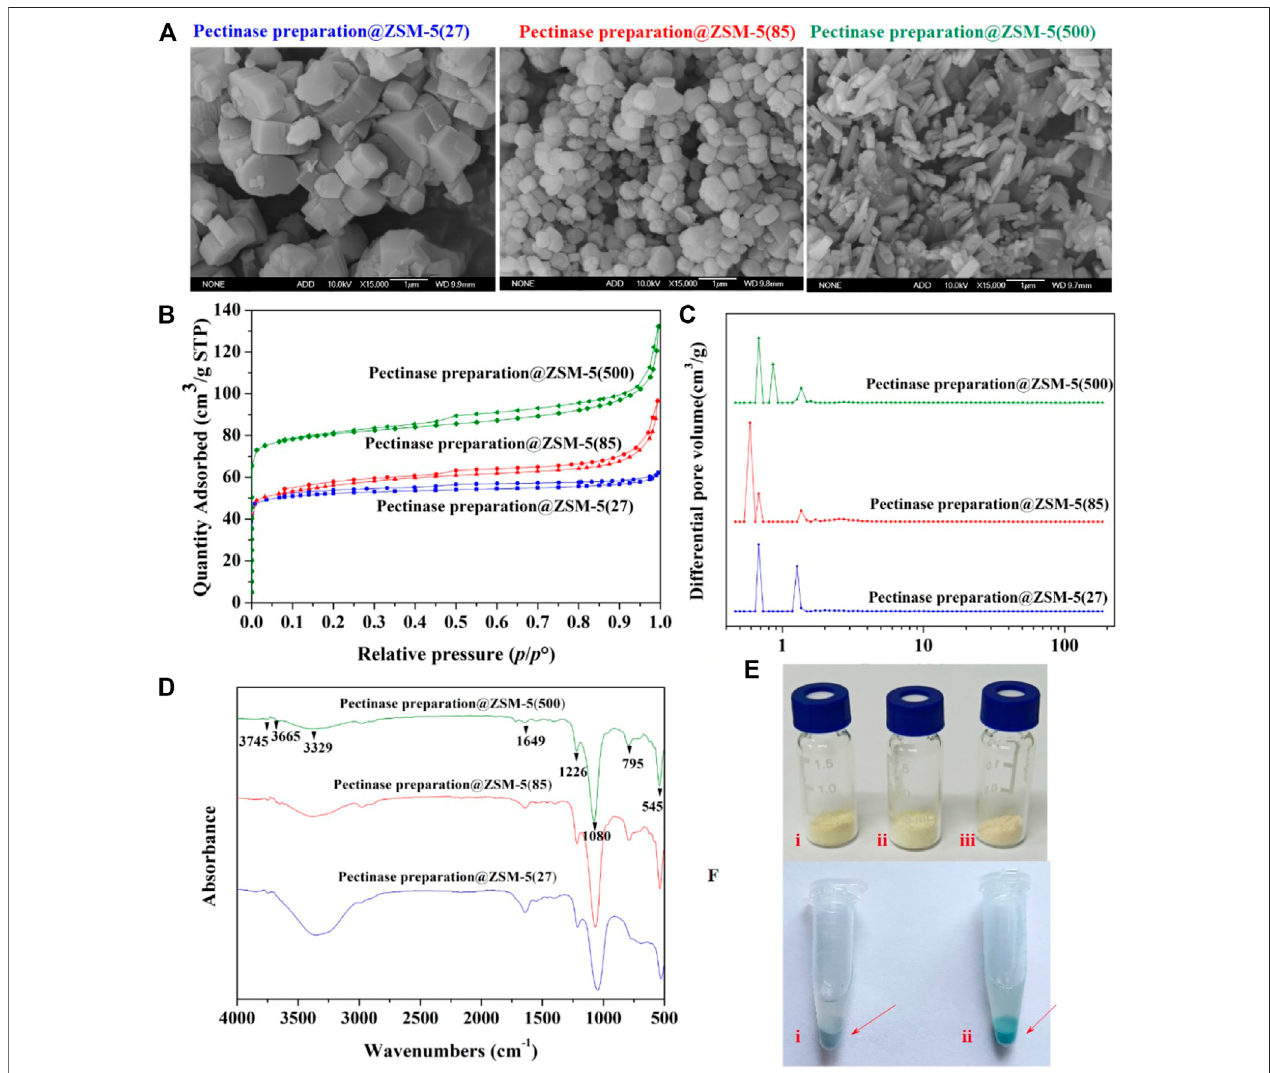
FIGURE 2 | Microstructure characterization for the pectinase preparation@ZSM-5 catalysts. (A) SEM images of pectinase preparation@ZSM-5(27), pectinase preparation@ZSM-5(85), and pectinase preparation@ZSM-5(500). (B) Nitrogen adsorption and desorption isotherms, and (C) corresponding pore-size distributions of pectinase preparation@ZSM-5 catalysts. (D) FT-IR spectra of pectinase preparation@ZSM-5. (E) Photographs of (i) pectinase preparation@ZSM-5 (27), (ii) pectinase preparation@ZSM-5(85), and (iii) pectinase preparation@ZSM-5(500). (F) Photographs of(i) ZSM-5 and (ii) pectinase preparation@ZSM-5 stained with Coomassie brilliant